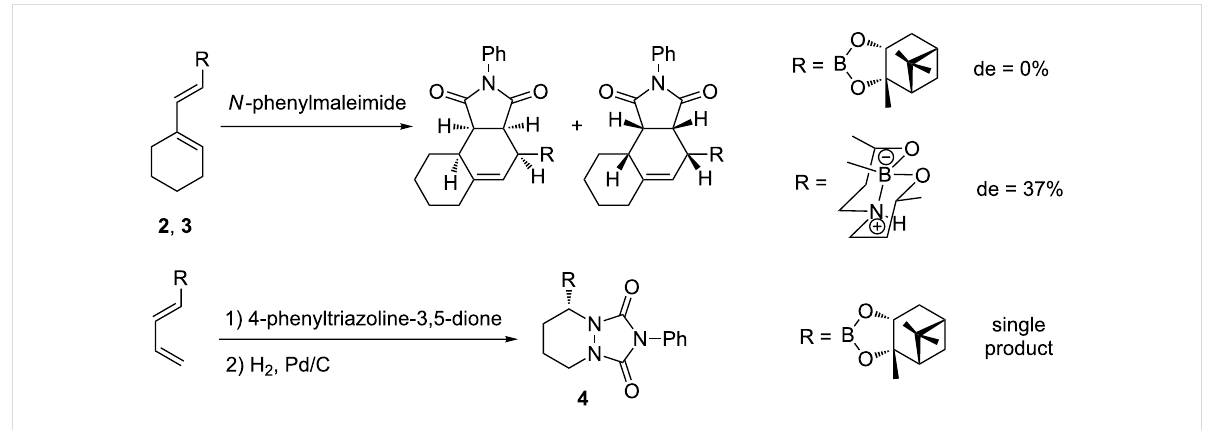
Scheme 5: Diastereoselective Diels–Alder reaction with N -phenylmaleimide and 4-phenyltriazoline-3,5-dione.